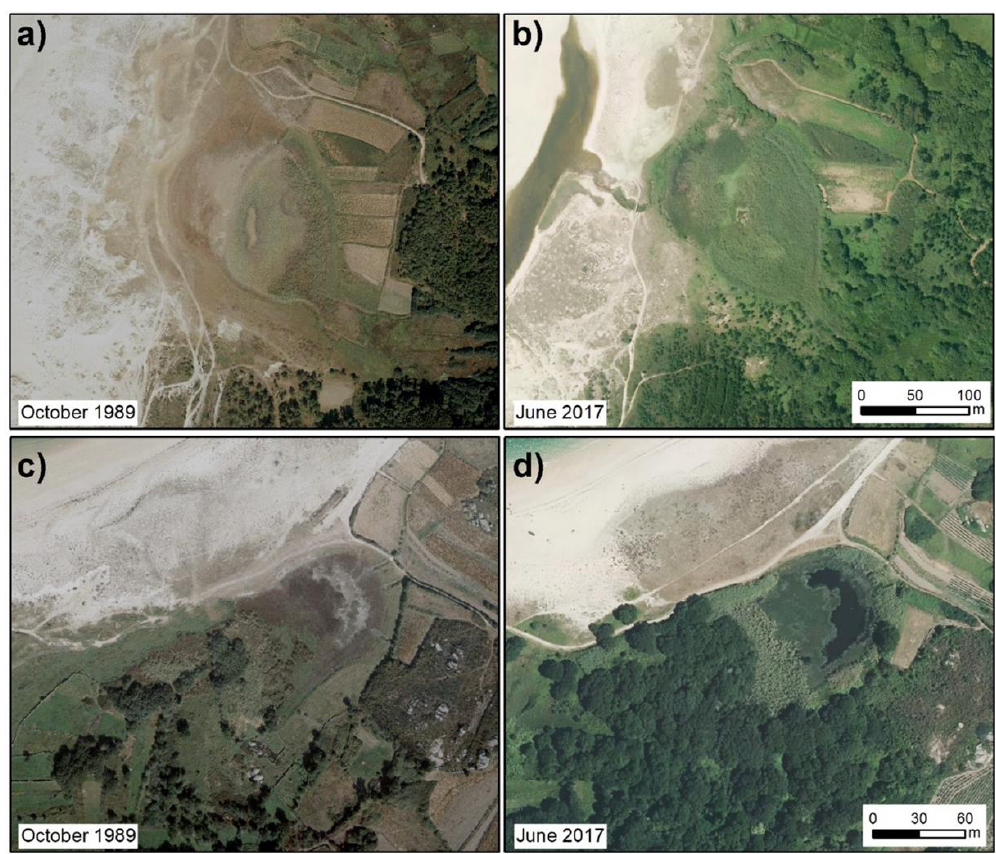
Figure 10. ( a , b ) represent the evolution of Xuño coastal lake between 1989 ( a ) and 2017 ( b – d ) show the evolution of Bodeira coastal lake between 1989 ( c ) and 2017 ( d ). Data: (IGN, [20]). An important factor to highlight in these images is the increase of alluvial forest in 2017 in relation to 1989, this habitat rises since 0.53 ha of continuous forest to 6.75 ha.